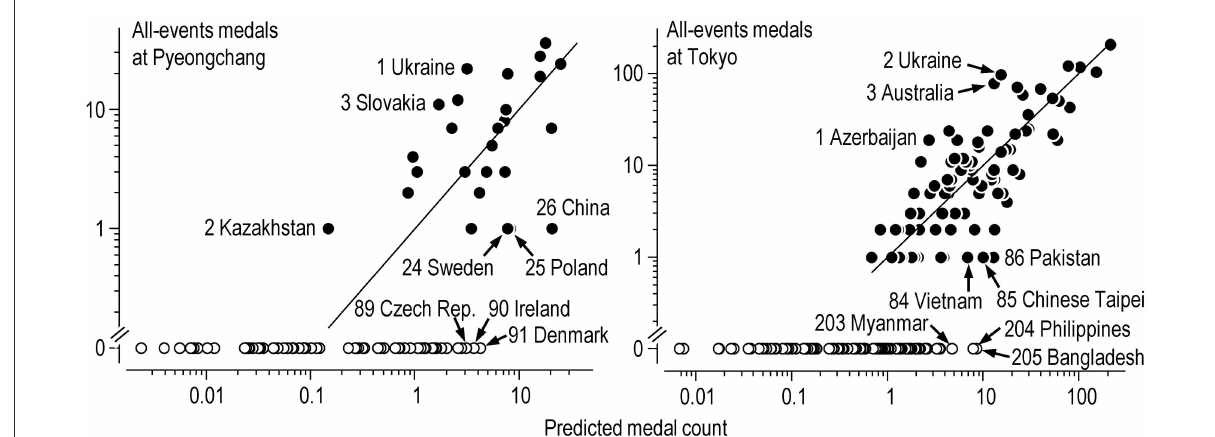
FIGURE1 All-events medal counts and medal counts predicted by the Poisson regression model at the Pyeongchang and Tokyo Olympics. Filled and open symbols are values for individual nations that won respectively at least one medal and no medals. For nations that won medals, the numbers on the labels represent the ranking based on the medal count as a factor of the predicted medal count (the vertical distance between the actual and predicted medal count, represented by the line of identity, in these log-log graphs). Ranking of nations that won no medals is based on the predicted medal count. Labels indicate the best three medalists, the worst three medalists, and the worst three non-medalists.